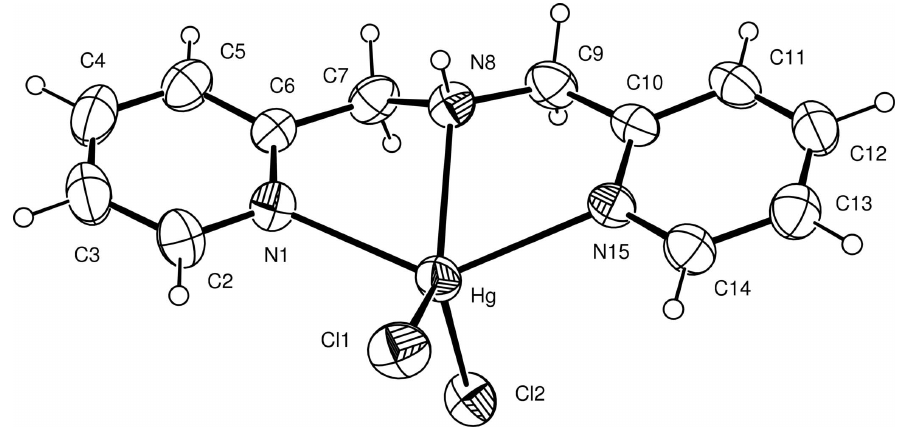
Figure 1 Molecular structure of (I), showing the atom-numbering scheme and 30% probability ellipsoids. Only the major component of the disordered atoms is shown for